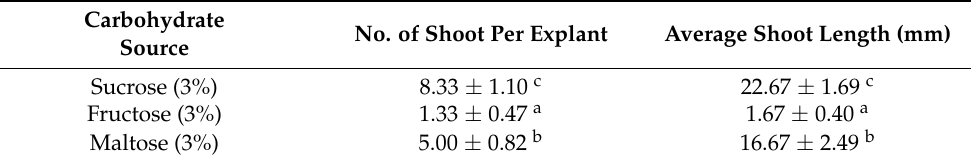
Table 3. Influence of carbohydrate source on shoot regeneration of L. chinense after six weeks